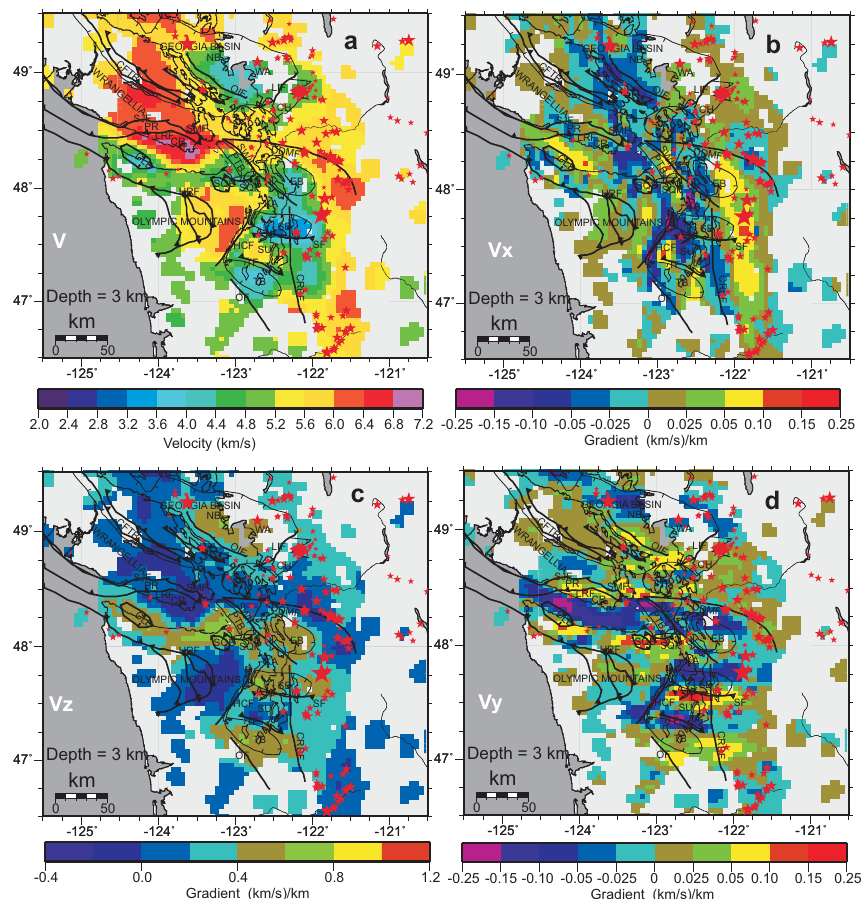
Fig. 7. Horizontal cross-section at 3km depth of (a) tomographic velocity model (b) X gradient of velocity model, (c) Z gradient of velocity model, and (d) Y gradient of velocity